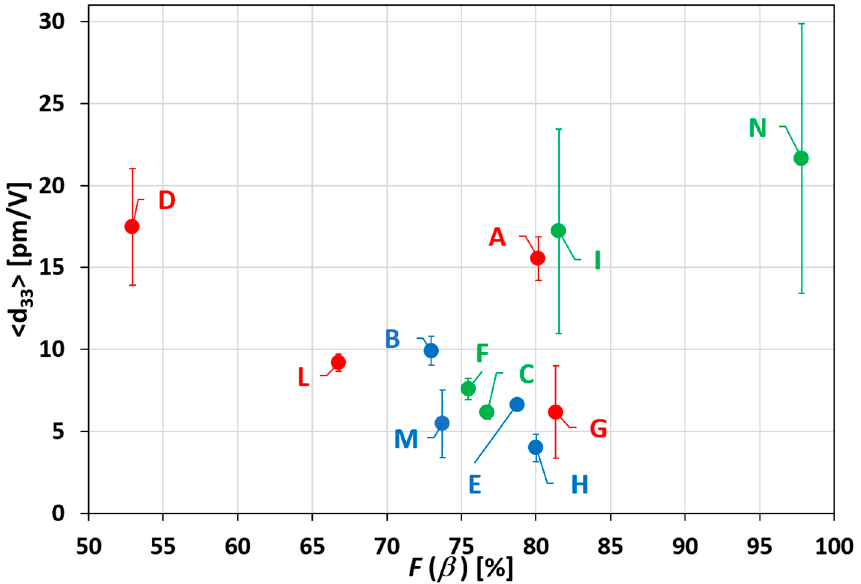
Figure 8. Results of the averaged d 33 as a function of 𝐹(β) of all produced samples, with standard